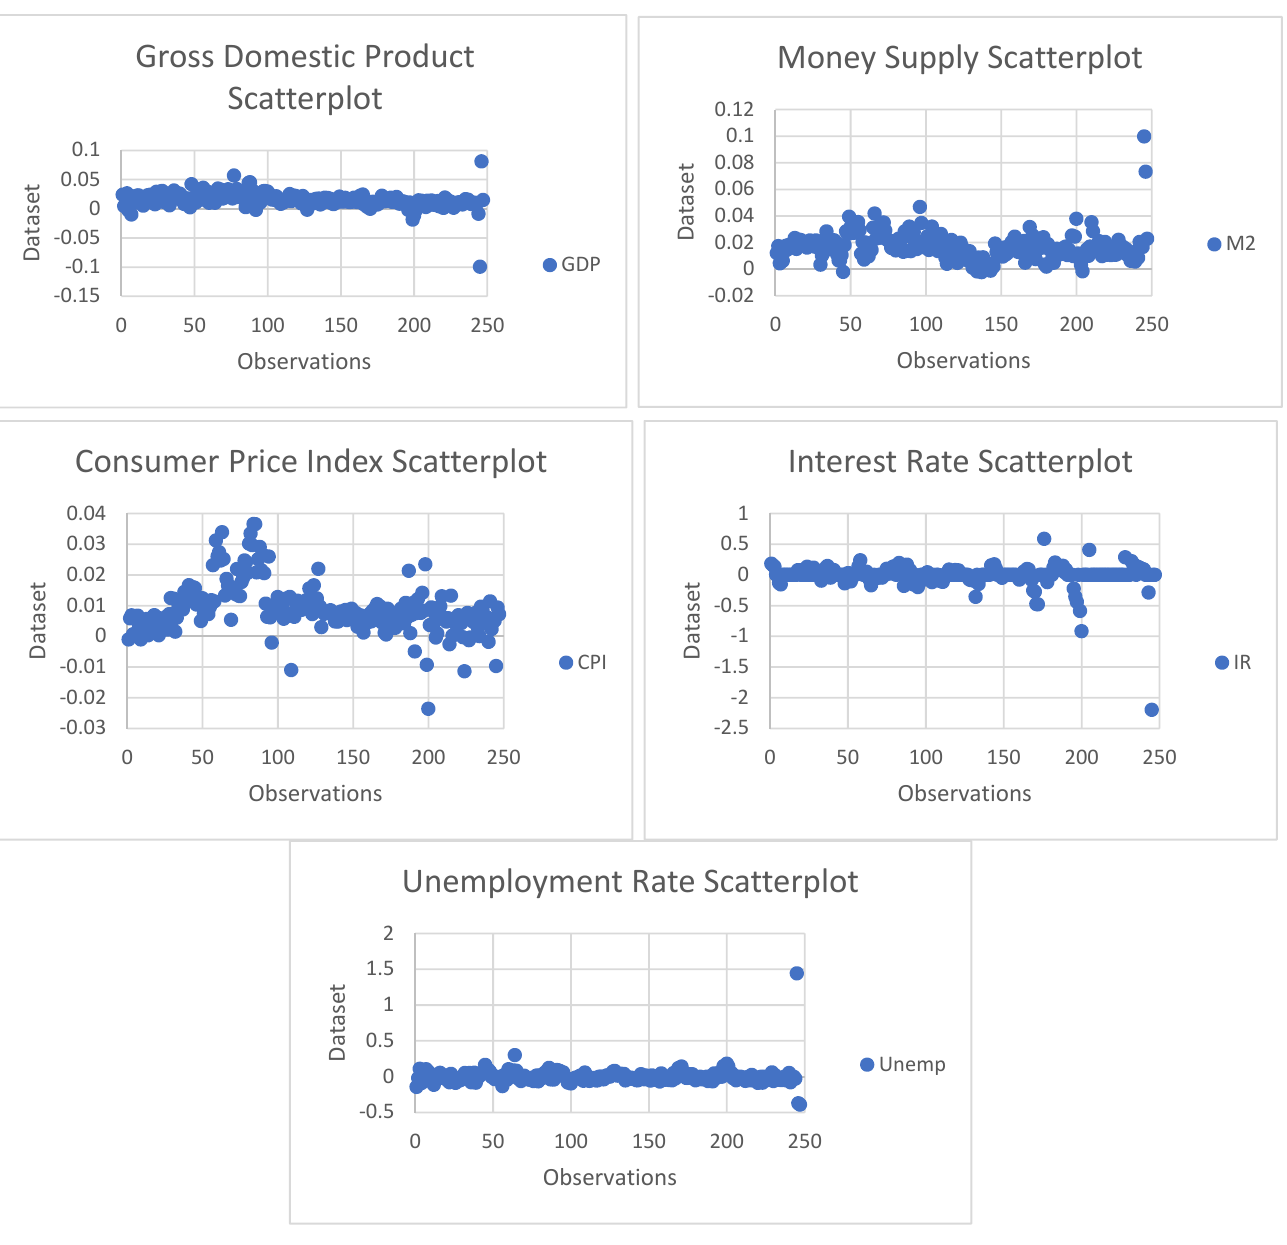
Figure 3. Scatterplot of GDP, M2, CPI, IR, and